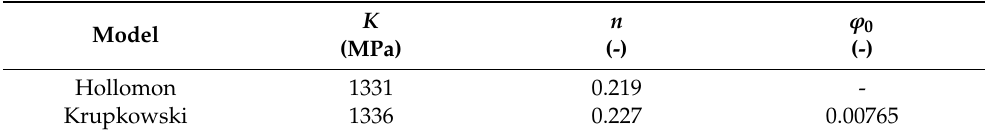
Table 4. Hollomon and Krupkowski material model constants.